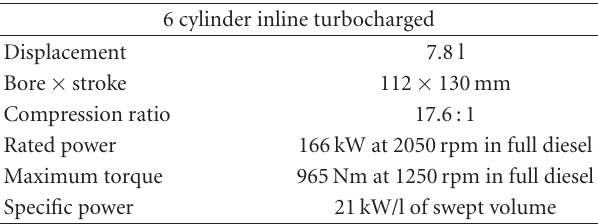
Table 3: Main characteristics of IVECO 8360.46R EURO II engine.